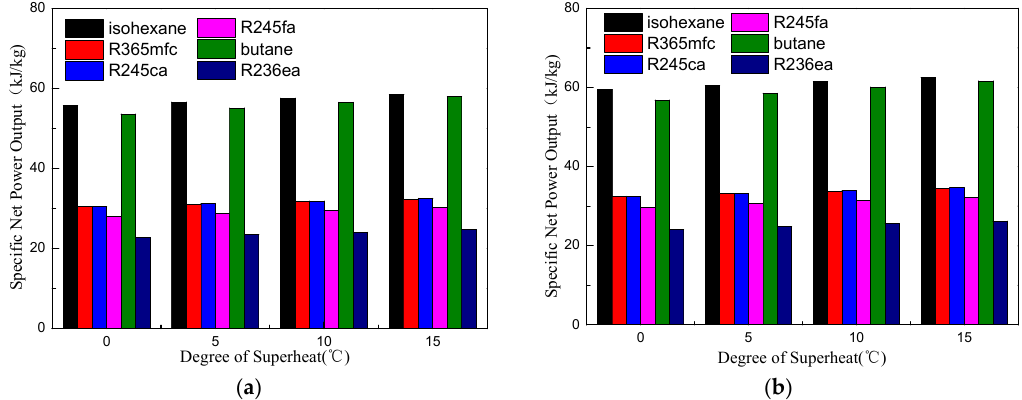
Figure 8. Comparisons of specific net power output for different working fluids at two evaporation temperatures: ( a ) Evaporation temperature at 95 °C; and ( b ) Evaporation temperature at 100 °C. Table 4. Latent heat of working fluids at two evaporation temperature.